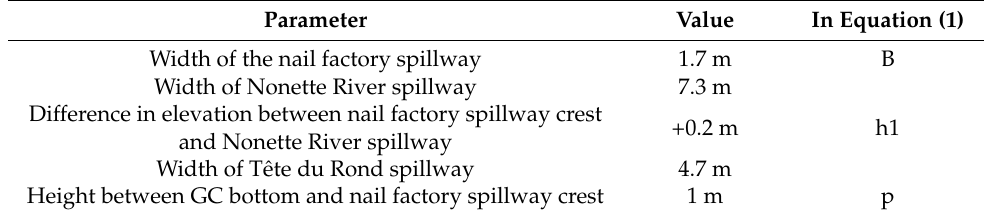
Table 9. Parameter values used to assess the flow rate distribution between the Hexagon and the T ê te du